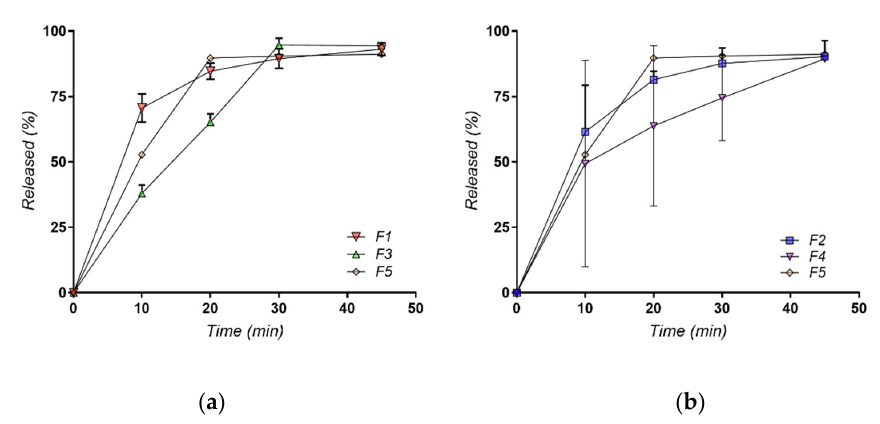
Figure 11. Dissolution profiles for formulations ( a ) F1, F3, F5 and ( b ) F2, F4, F5.